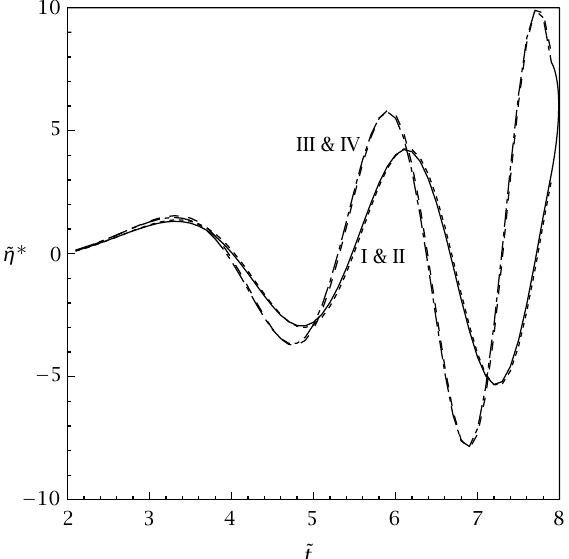
Figure 5.4 . Wave profiles due to an initial disturbance in the form of an impulse ( ˜ x = 1 . 0 ) , (cid:5)/h = 0 . 01, N 2 h/g = 0 . 1 I; (cid:5)/h = 0 . 01, N 2 h/g = 0 . 0 II; (cid:5)/h = 0 . 0, N 2 h/g = 0 . 1 III; (cid:5)/h = 0 . 0, N 2 h/g = 0 . 0